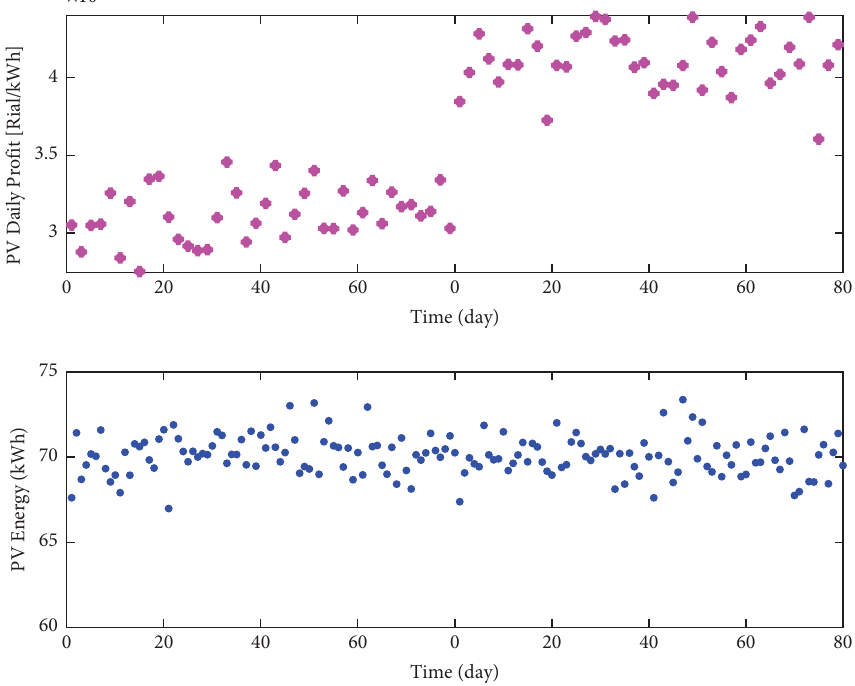
Figure 5: Average daily proft and output power of PV.